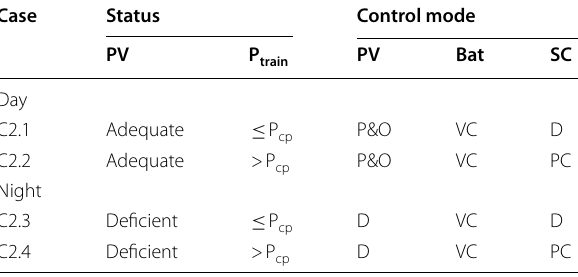
Table 2 Port state and control mode for acceleration